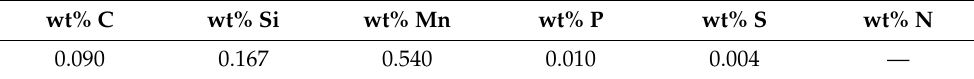
Table 1. Amount of alloying elements of analyzed galvanized plates. wt% C